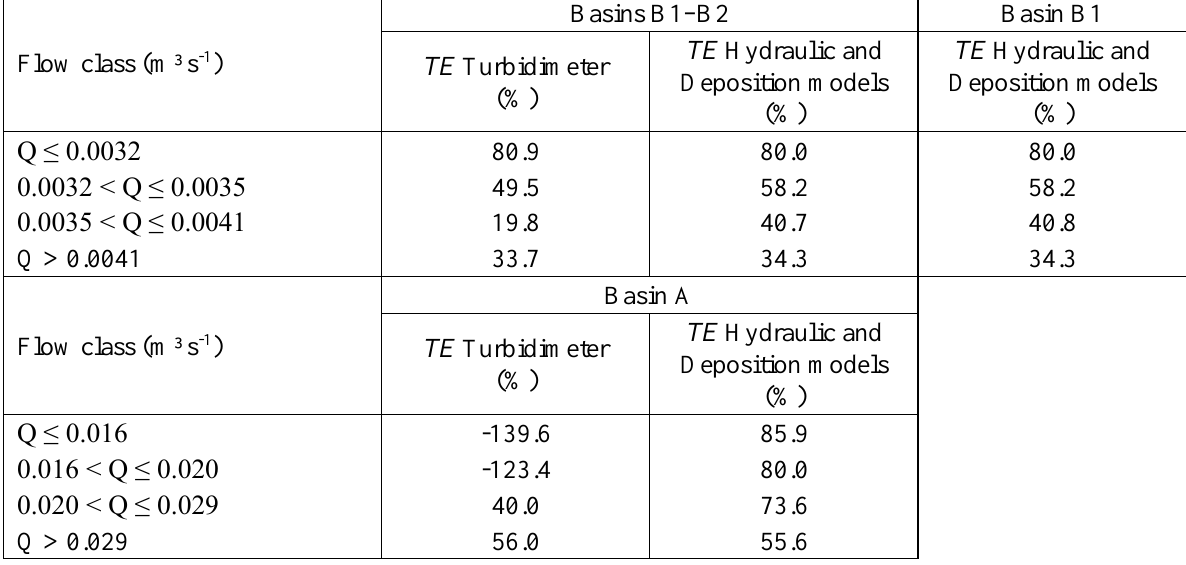
Table 5. Trapping efficiency ( TE ) of Basins B1–B2 in series, Basin B1 and Basin A, calculated using SS concentrations and the hydraulic and deposition